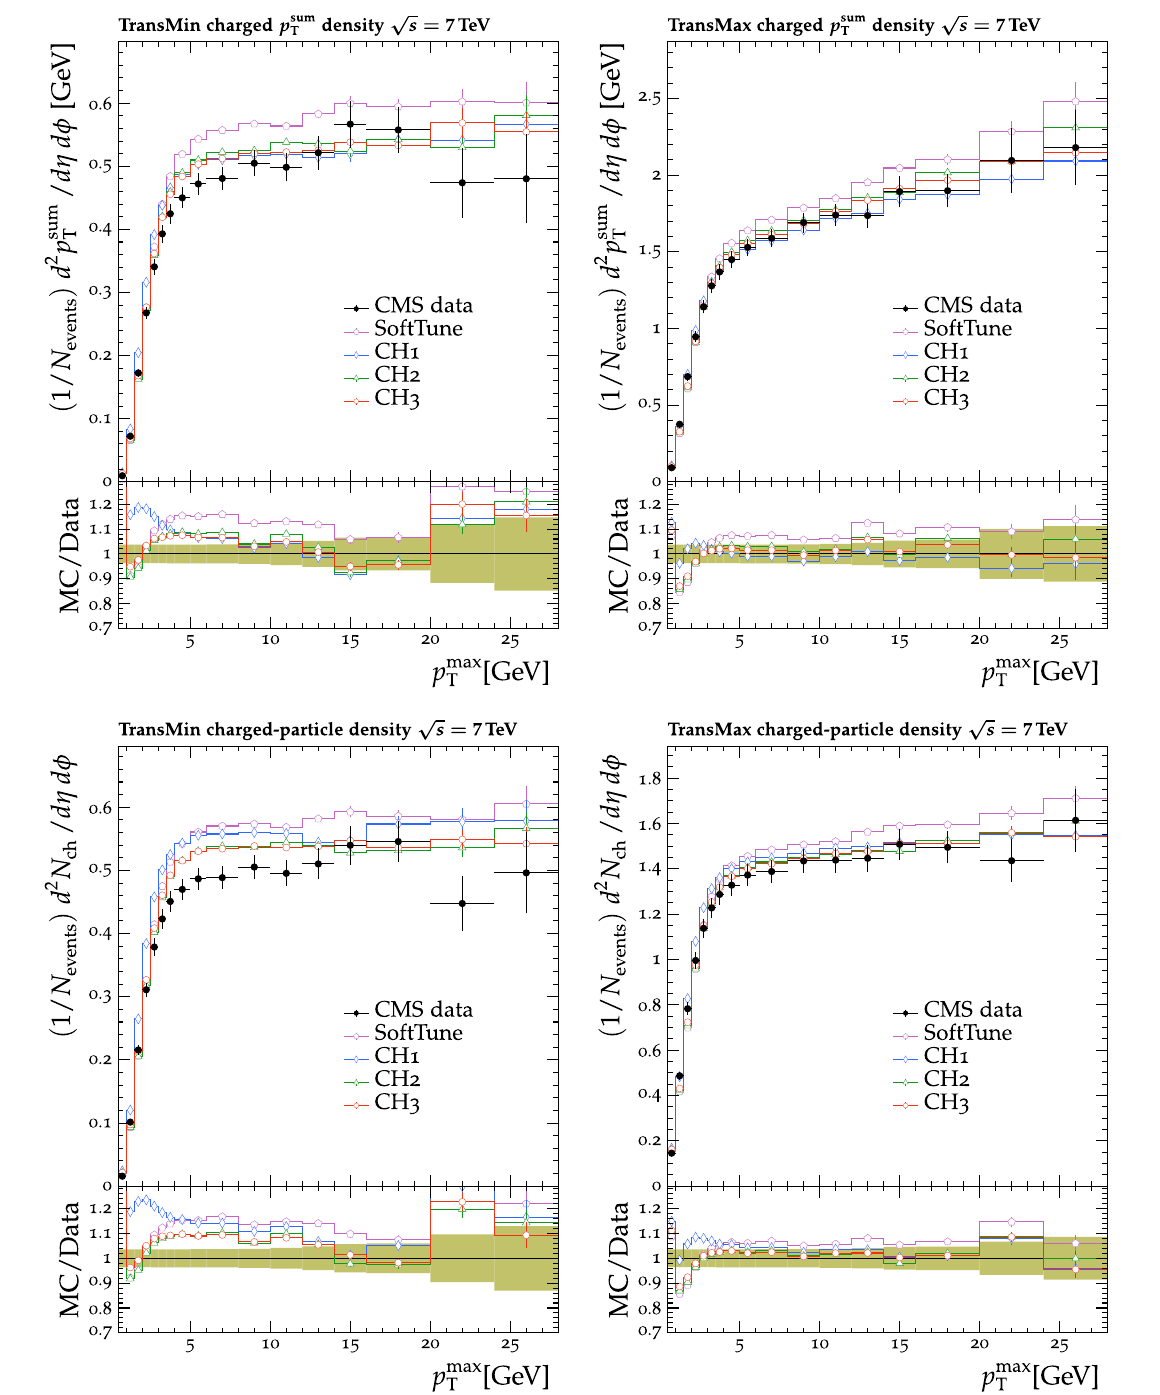
Fig. 4 The p sum (upper) and N ch (lower) density distributions in the T transMin (left) and transMax (right) regions, as a function of the p T of the leading track, p max [23]. CMS MB data are compared with the pre- T dictions from herwig 7, with the SoftTune and CH tunes. The coloured